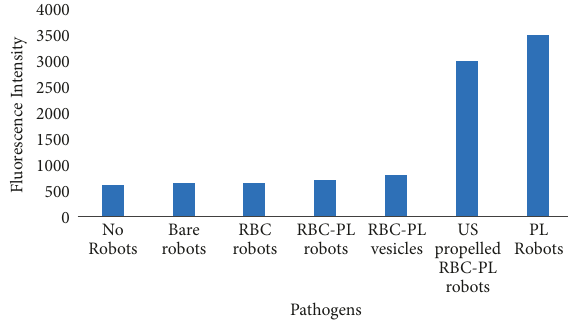
Figure 7: DAPI-stained normalized fluorescence